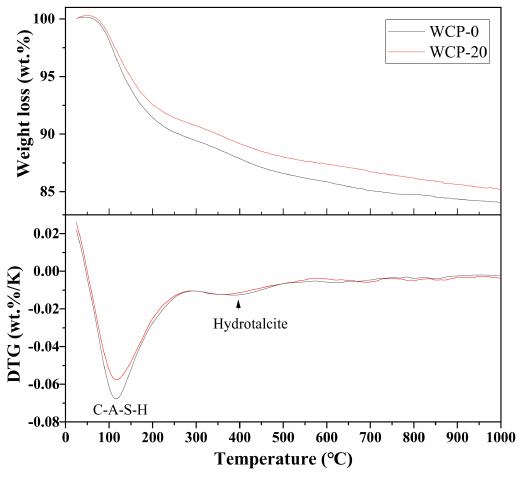
Figure 7. TG-DTG curves of